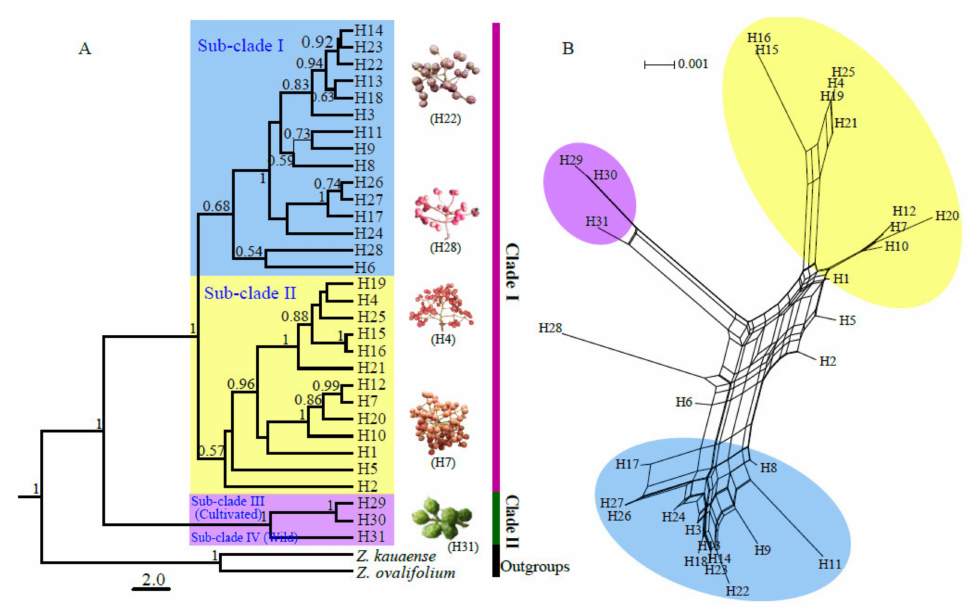
Figure 3. Genetic structure of Chinese pepper. ( A ) MCC tree from the BEAST analysis based on the dataset of two nrDNA markers of 31 haplotypes. The values of posterior probability larger than 0.5 were labeled in the tree. Z. kauaense and Z. ovalifolium were used as outgroups. ( B ) A neighbor-net tree constructed from a concatenation of ITS2 and ETS markers from 31 haplotypes using